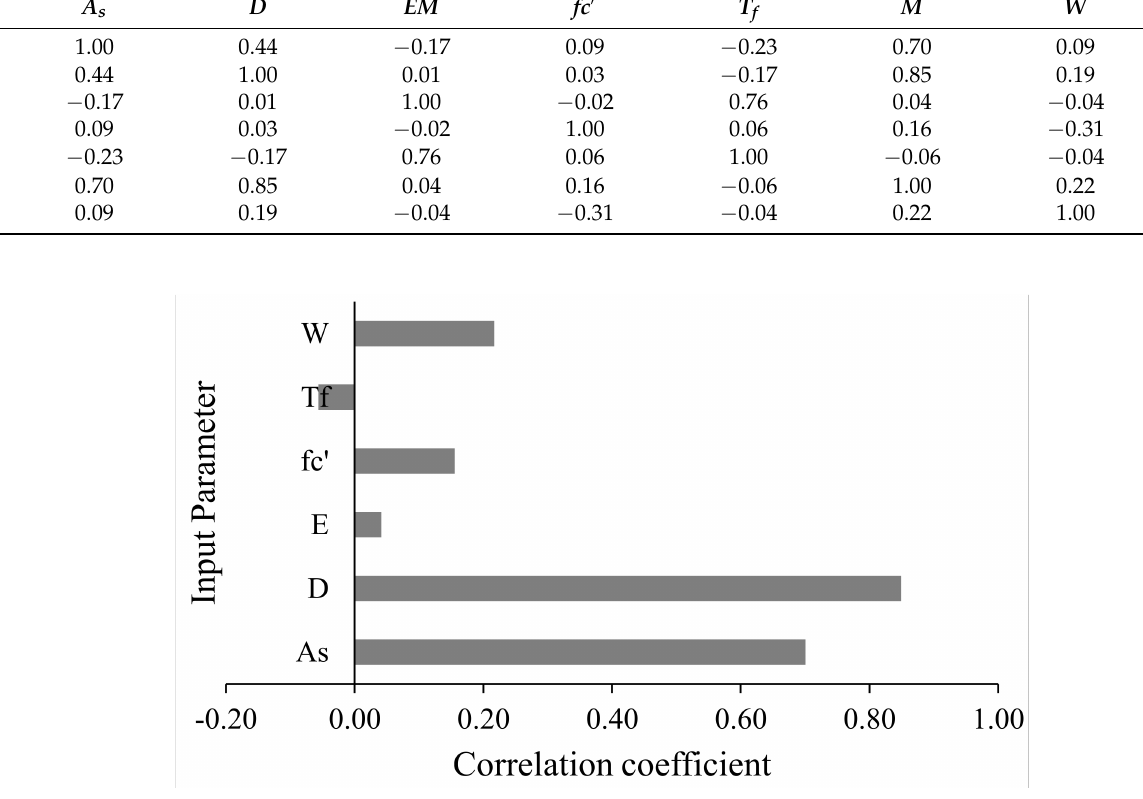
Figure 3. Correlation strength between input and output